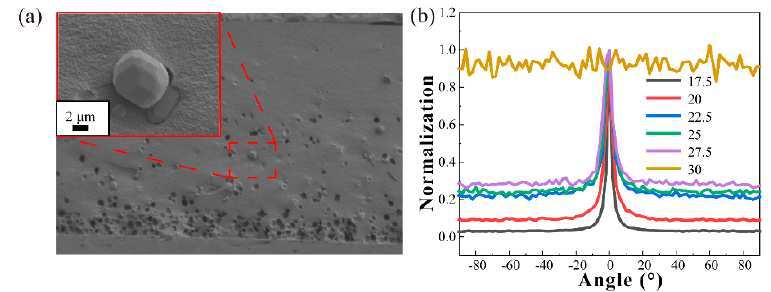
Figure 4. ( a ) The scanning electron microscope (SEM) images of microphosphor particles; ( b ) the scatter characteristics of phosphor converters with different concentrations.